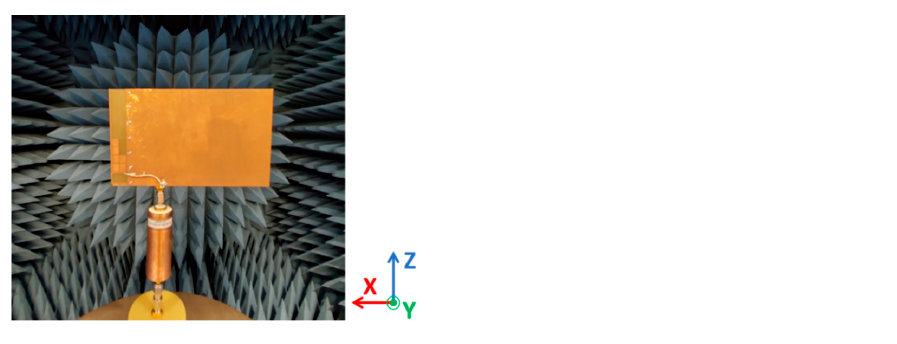
Figure 9. Measurement setup in Howland 2100D anechoic chamber for radiation patterns. Table 4. Comparison of the simulated and measured radiation patterns for the four fabricated IFAs. Simulated Current Distribution (A/m)